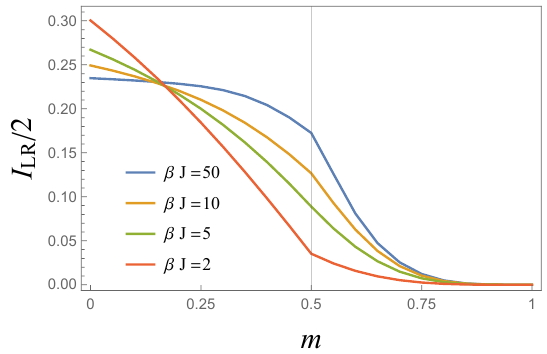
Figure 19. Renyi-2 mutual information I (2) (Φ( m )) between unmeasured Majorana fermions on LR the left and right sides for the two-sided measurement case. m = M/N is the ratio of measured Majorana fermions on the left and right sides. The mutual information is always non-vanishing for m < 1 , and vanishes only when all the Majorana fermions are measured ( m = 1 ).